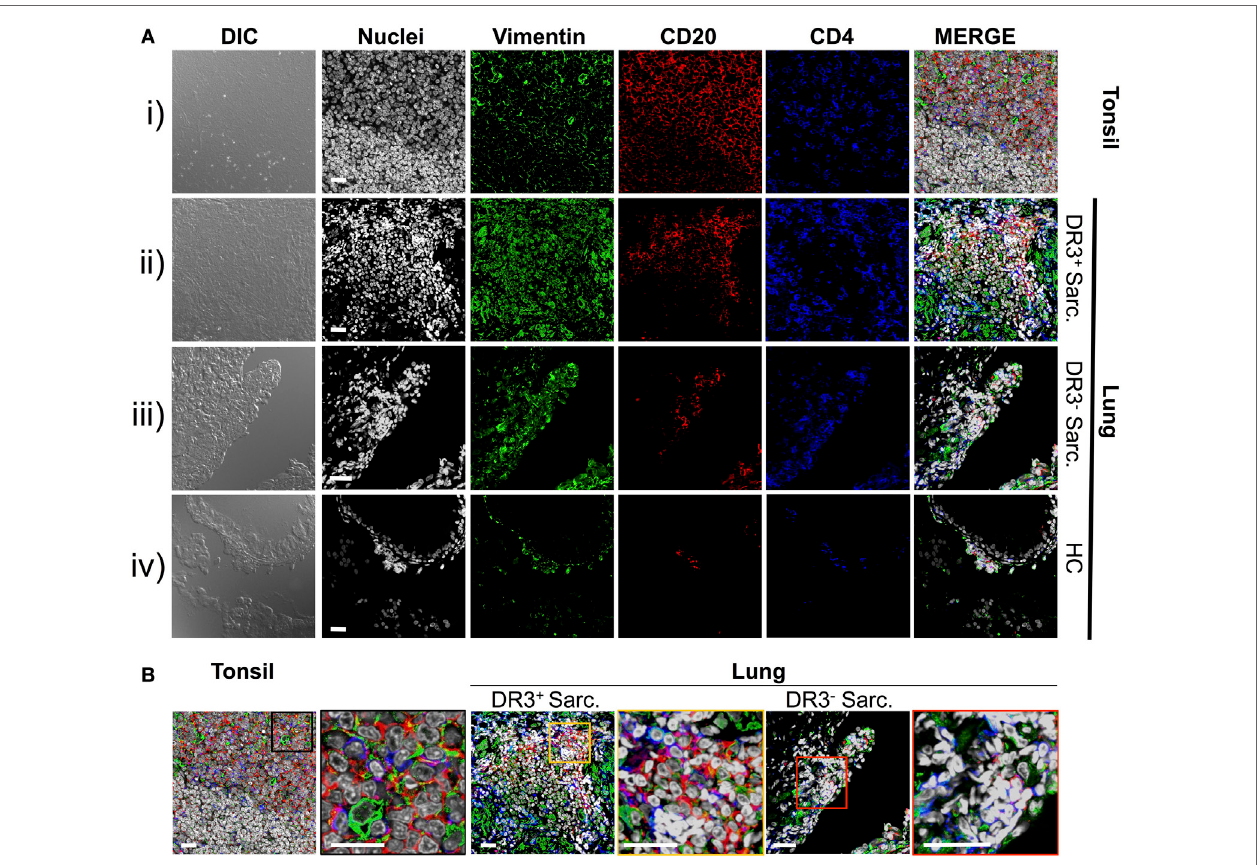
FigUre 2 | Vimentin, B-cells, and T-cells accumulate and co-localize in sarcoid lung. Specificities of anti-vimentin, anti-CD20 (B-cells), and anti-CD4 (T-cells) antibodies were confirmed by multi-colored immunofluorescence staining of human tonsil [ (a) i]. Detection was performed using fluorophore-labeled secondary antibodies and false colors subsequently assigned to respective wavelength’s acquired channel. Nuclei were counter-stained with Hoechst. Digital image contrasts of the tissue were also acquired. Analogous stains were performed on HLA-DRB1*03 + Löfgren’s syndrome (LS) [ (a) ii], HLA-DRB1*03 − non-LS [ (a) iii], and healthy [ (a) iv] mucosal biopsies. Examples of the highest orders of lymphoid organization for each patient group are provided. Magnified areas of merged channels from (a) for the respective tissues (as labeled) showing areas positive for vimentin, B-cells, and T-cells are focused on in (B) . Negative control images can be found in Supplementary Material. Images were acquired with an oil immersion 40 × objective. Scale bar length = 25 µm. Colored boxes correspond to highlighted areas of interest magnified from adjacent